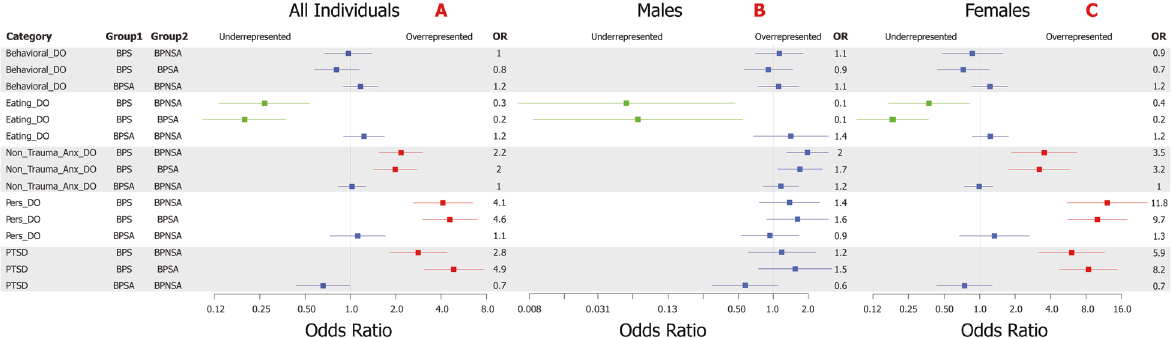
Fig. 1 BPS versus BPSA and BPNSA clinical category analysis results. Forest plot distribution of corrected odds ratios of the primary clinical category comparisons (with 95% con fi dence interval represented by whiskers) within all individuals ( A ), males ( B ), and females ( C ). Labeling of comparison groups is as follows: BPS = individuals with bipolar disorder who died by suicide, BPSA = individuals with bipolar disorder who have a history of one or more suicide attempts, and BPNSA = individuals with bipolar disorder who have no history of a suicide attempt. Signi fi cant results are colored with overrepresentation shown in red and underrepresentation in green. Non-signi fi cant results are shown in blue. Results were corrected for multiple testing via the Benjamini – Hochberg method with an FDR of 0.05 for a total of 15 tests in the primary analysis ( A ) and 30 in the sex-speci fi c analyses ( B , C ) and for critical Secondary sex-speci fi c results are shown in Fig. 1B and C. Fig. 1. All results are corrected for multiple testing and covariates. Females strongly drove overrepresentations of PTSD (OR = 8.2, BPS versus BPSA showed overrepresentation for diagnoses of 95%CI = 4.7 – 14.4; P = 3.4 × 10 − 11 ), personality disorder (OR = 9.7, PTSD (OR = 4.9, 95%CI = 3.1 – 7.6; P = 6.0 × 10 − 11 ), personality disorders (OR = 4.6, 95%CI = 3.0 – 7.0; P = 2.2 × 10 − 11 ; noting the 95%CI = 5.5 – 17.4; P = 4.5 × 10 − 13 ), and non-traumatic anxiety caveat discussed in the limitations), and non-traumatic anxiety disorder (OR = 3.2, 95%CI = 1.7 – 5.7; P = 6.1 × 10 − 4 ) in BPS versus BPSA. Females also drove the reduced rate of eating disorder disorders (OR = 2.0, 95%CI = 1.4 – 2.8; P = 1.3 × 10 − 4 ). Eating dis- diagnoses in BPS versus BPSA (OR = 0.2, 95%CI = 0.1 – 0.4; P = order diagnoses were signi fi cantly reduced within BPS versus 1.1 × 10 − 5 ). Though male BPS versus male BPSA showed nominal BPSA (OR = 0.2, 95%CI = 0.1 – 0.4; P = 2.2 × 10 − 6 ). No comparisons were signi fi cant between BPSA and BPNSA.